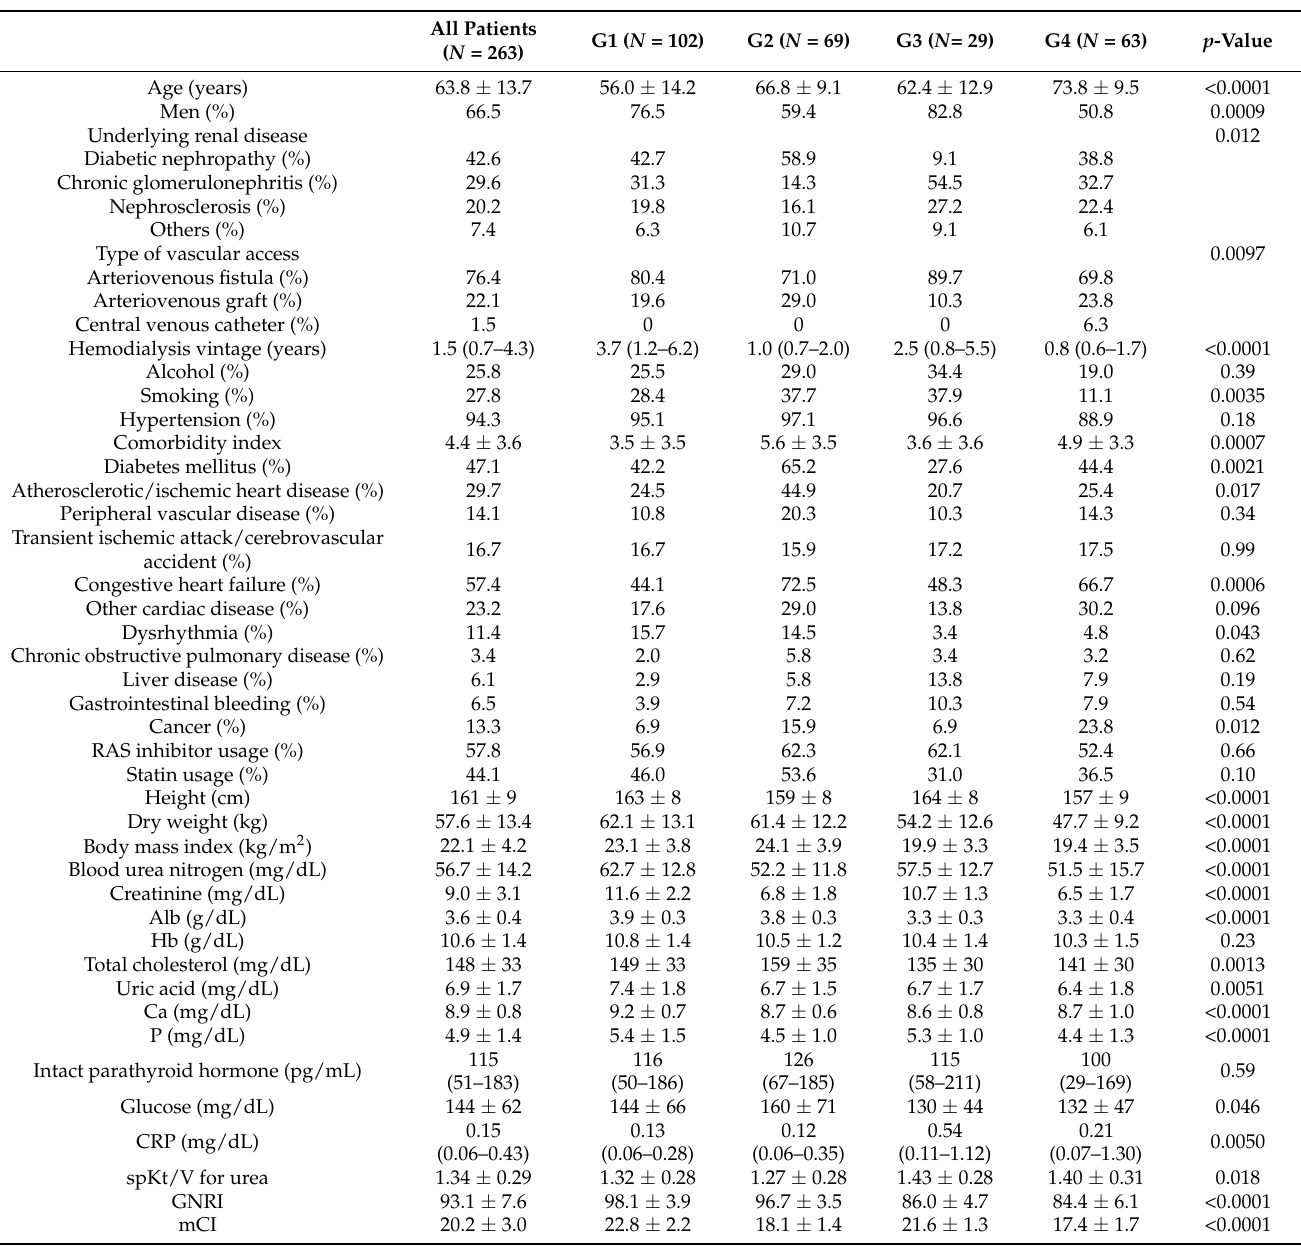
Table 1. Baseline patient